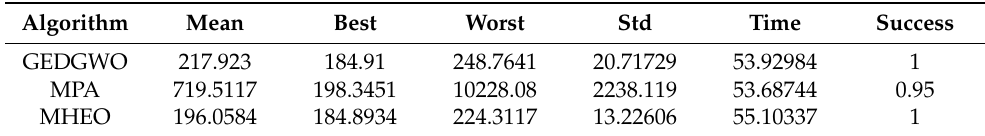
Table 4. Comparison of path planning results (Threat).